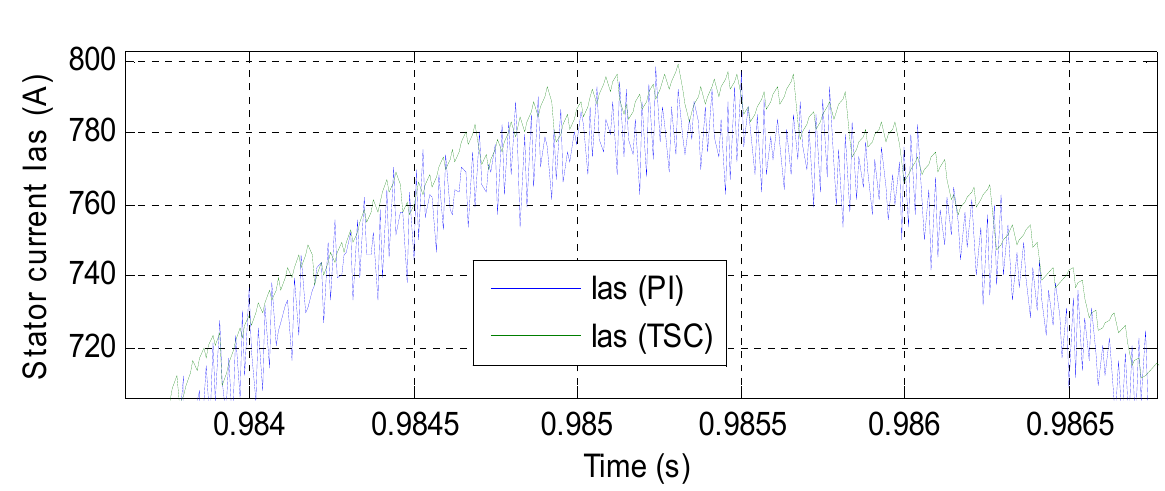
Figure 13. Zoom (Torque).